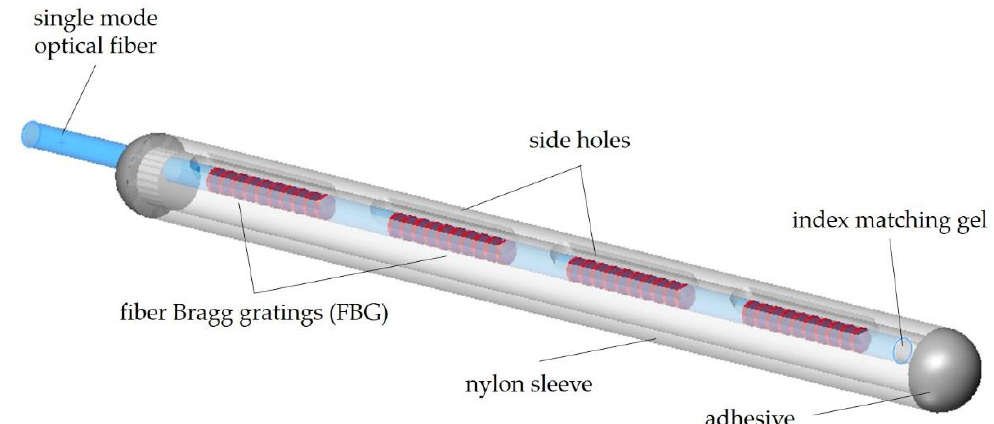
Figure 6. Schematic drawing of the temperature sensor proposed by Rao et al. (Adapted from [108].) A nylon sleeve was made transparent to allow component visualization.